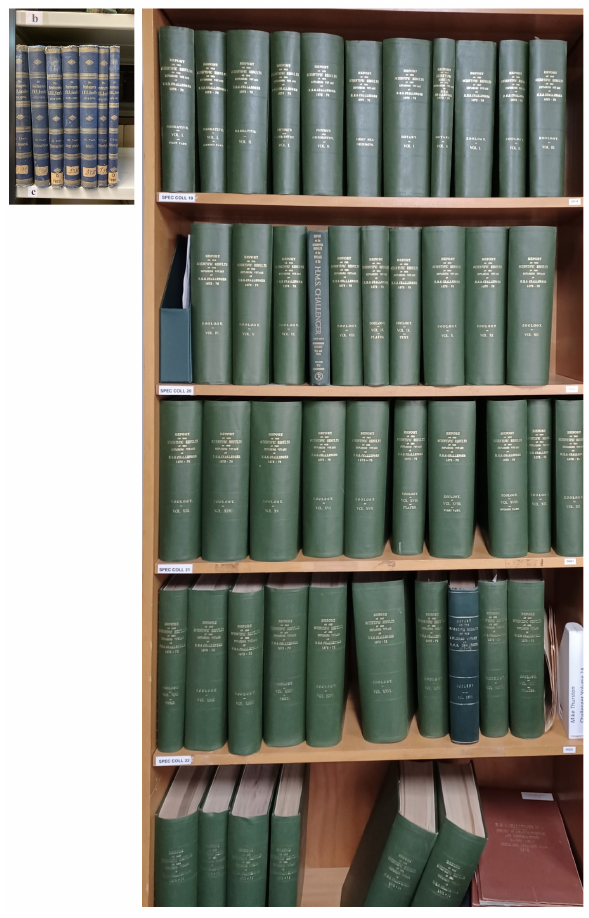
Figure 7. An almost complete set of Challenger reports (National Oceanographic Library, Southampton) and the Gazelle reports to the same scale. (Walter Zenk, GEOMAR Helmholtz-Zentrum für Ozeanforschung,